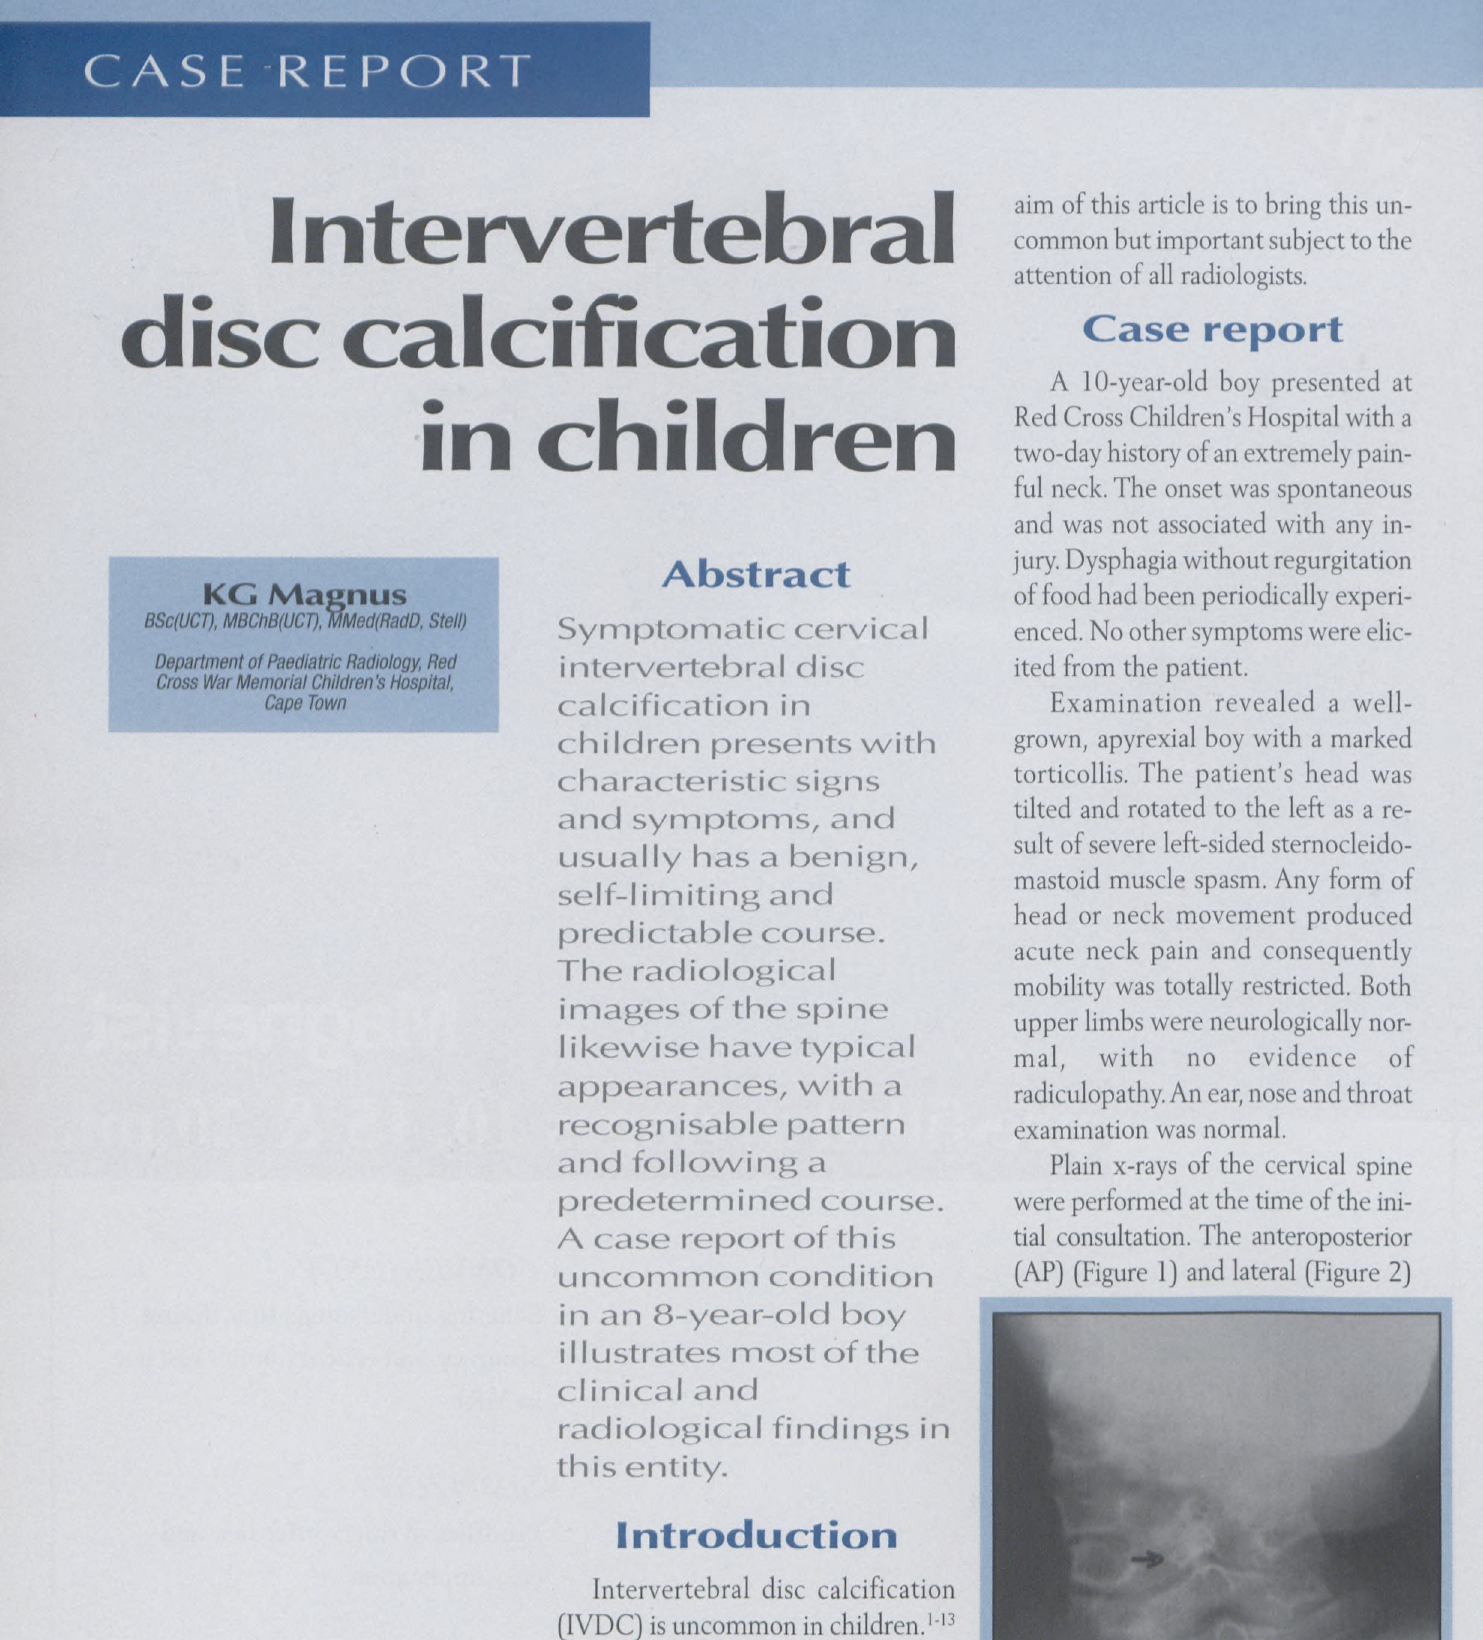
Figure 1: AP cervical spine x-ray. Chin tilted and rotated to the left. Scoliosis convex to the right. Dense, oval shaped, central calcified intervertebral disc (arrow) at C5/6 level.